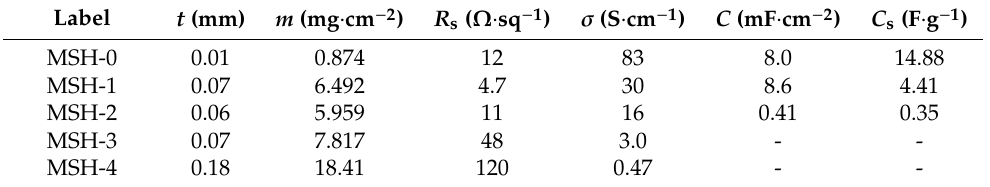
Table 3. Thickness ( t ), mass ( m ), sheet resistivity ( R s ), electrical conductivity ( σ ), capacitance ( C ),